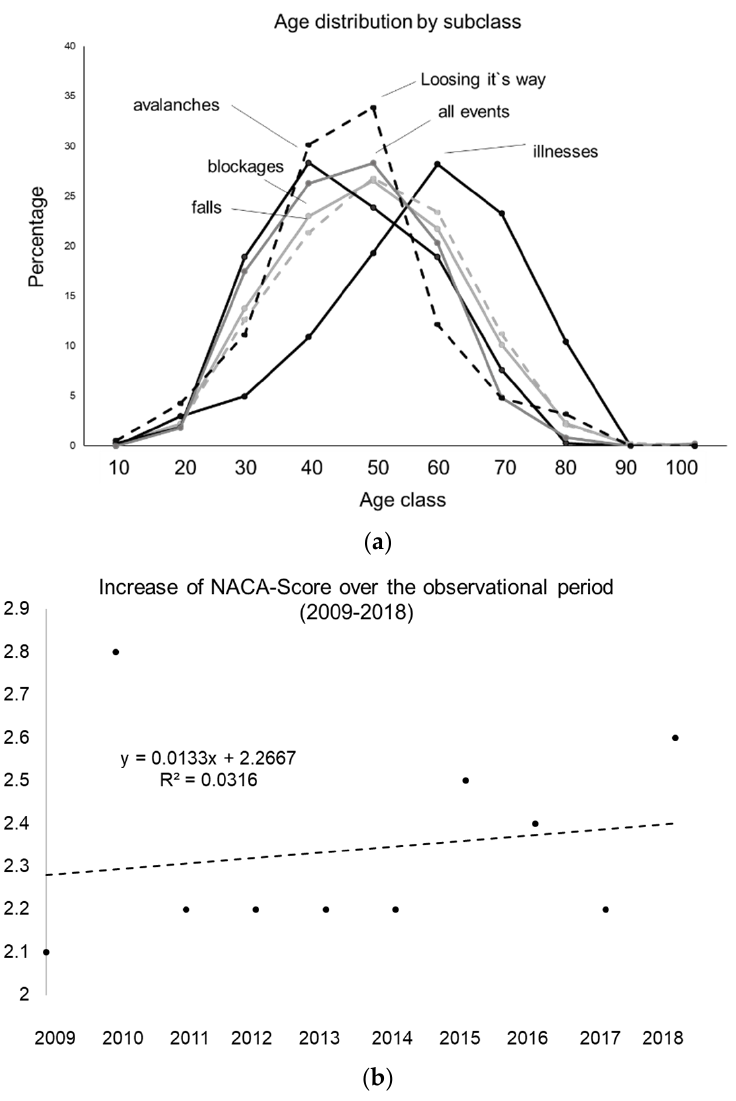
Figure 2. ( a ) A percentage age distribution of the shares in the respective classes. ( b ) The development of the NACA-Score over the observational period.